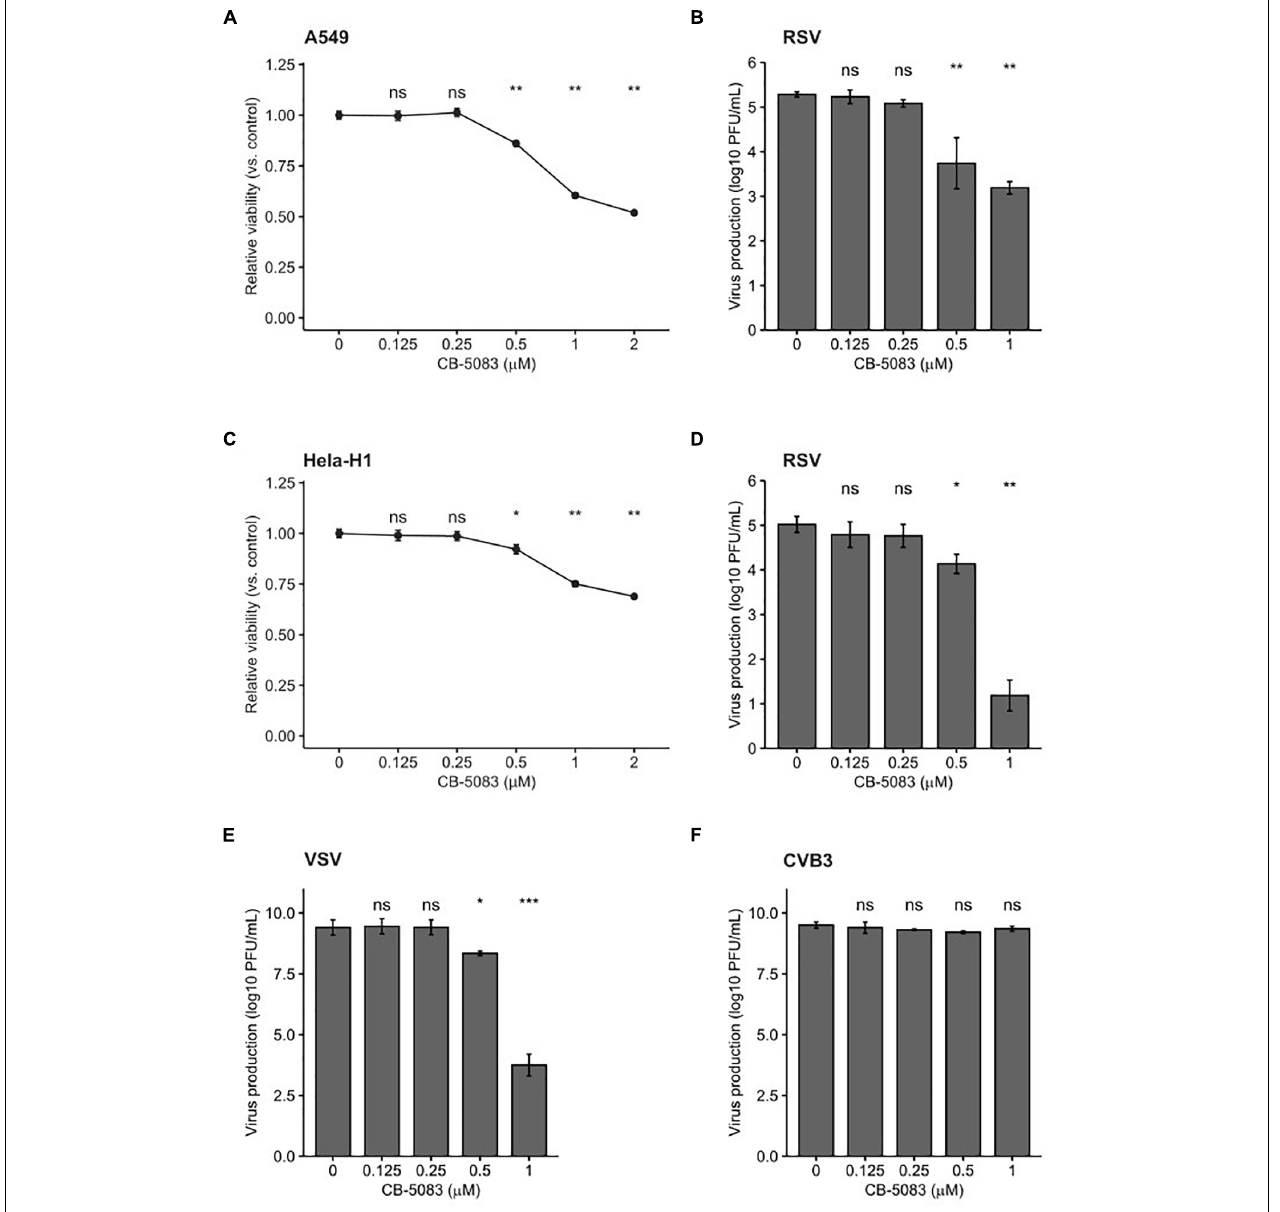
FIGURE 2 | VCP/p97 inhibition reduces RSV and VSV production. (A) The effect of the VCP/p97 inhibitor CB-5083 on A549 cell viability ( n = 6). (B) The effect of CB-5083 on RSV virus production in A549 ( n = 6). (C) The effect of the VCP/p97 inhibitor CB-5083 on Hela-H1 cell viability ( n = 6). (D,E) The effect of CB-5083 on RSV ( n = 7) (D) , vesicular stomatitis virus (VSV) ( n = 7) (E) , or coxsackievirus B3 (CVB3) production ( n = 4). (F) Virus production in Hela-H1 cells. Results indicate the mean and SEM. ns p > 0.05; * p < 0.05; ** p < 0.01; *** p < 0.001 by a two-tail, unpaired Mann-Whitney test/Wilcoxon rank sum exact